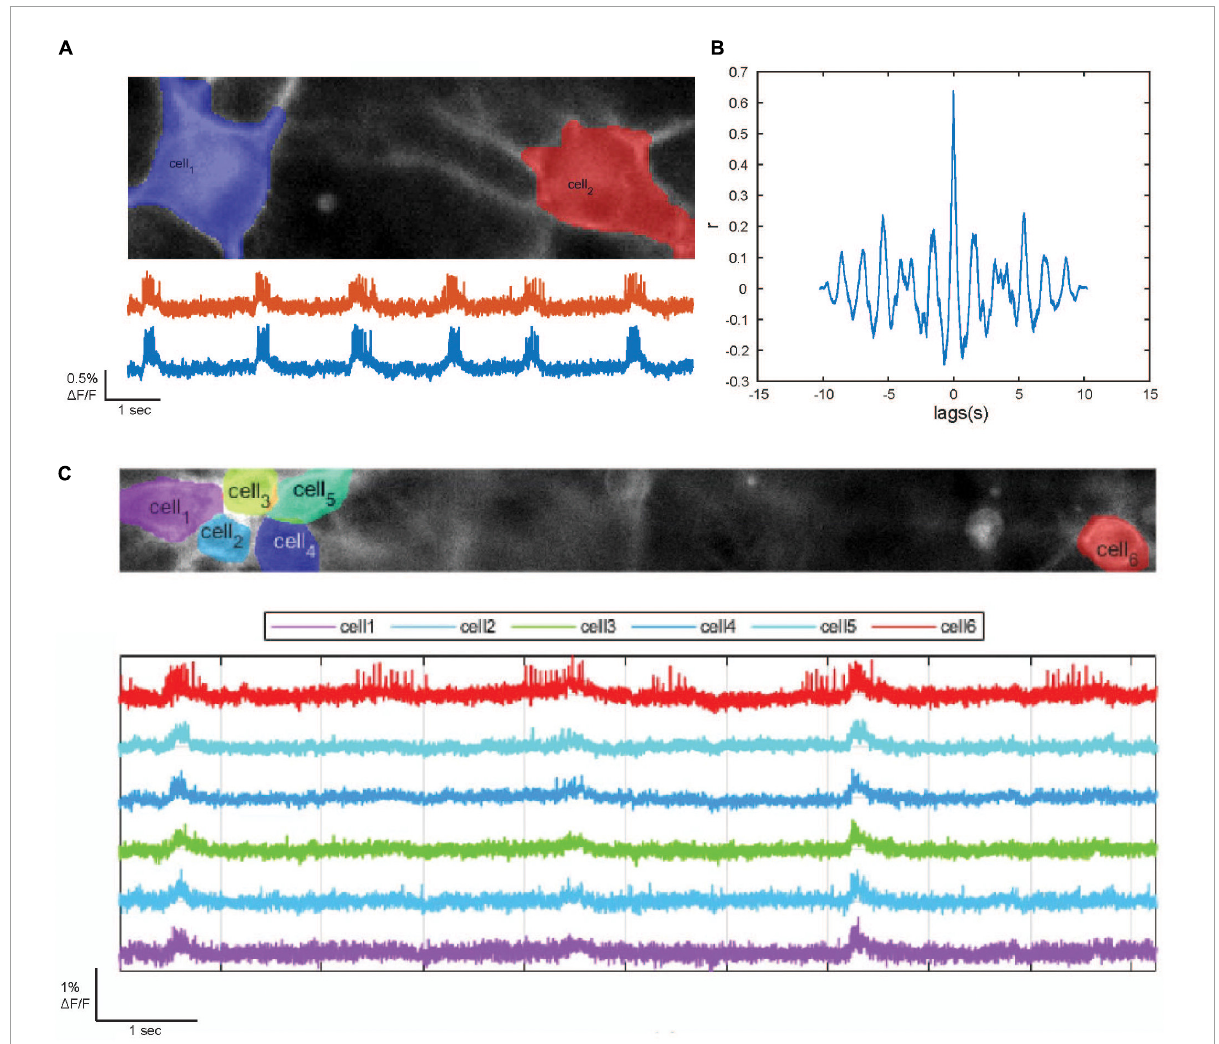
FIGURE5 Optical detection of epileptogenic bursting behavior in human induced pluripotent stem cell (hiPSC)-derived forebrain neurons [induced forebrain glutamatergic neurons (iGluN) (80%) and GABAergic neurons (iGABAN) (20%)]. (A) Top: Automated detection of the somata of two example hiPSC-derived iGluN iGABAN neurons. (B) Cross-correlation between the fluorescence traces of two example neurons. (C) Upscaling of the dark quencher hybrid genetically encoded voltage indicator (dqGEVI) imaging system. Top: Automated detection of the somata of six hiPSC-derived forebrain neurons. Bottom: respective fluorescence